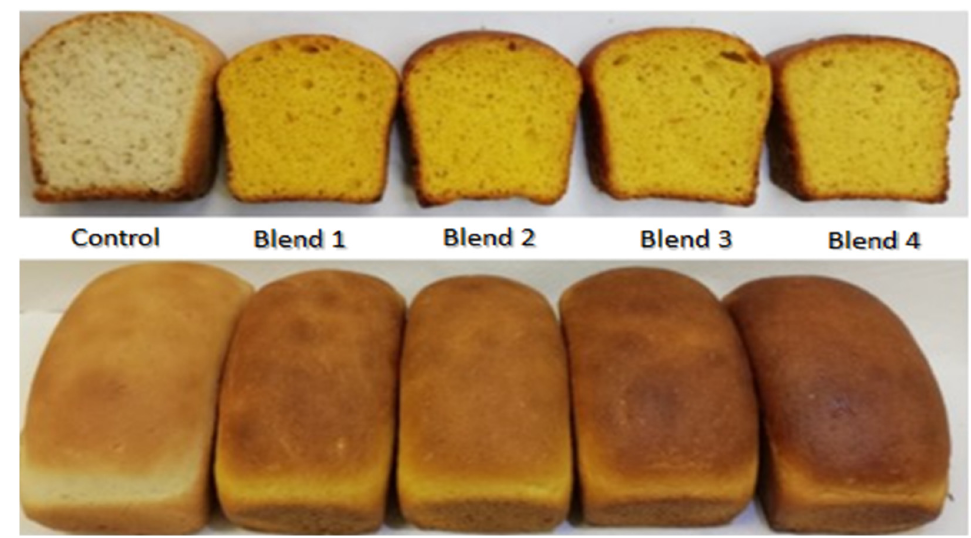
Figure 2. Appearance of the crusts and crumbs of the loaves made with the optimum blends of wheat, amaranth and orange sweet potato flours. Table 5. Specific volume and textural characteristics of the breads made with wheat flour and the optimal blends.